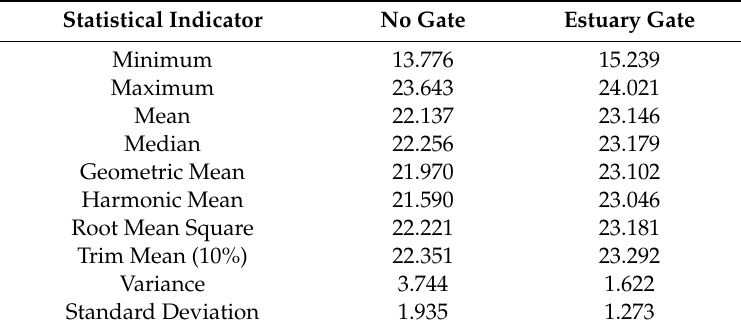
Table 1. Descriptive analysis of salinity (% (cid:24)